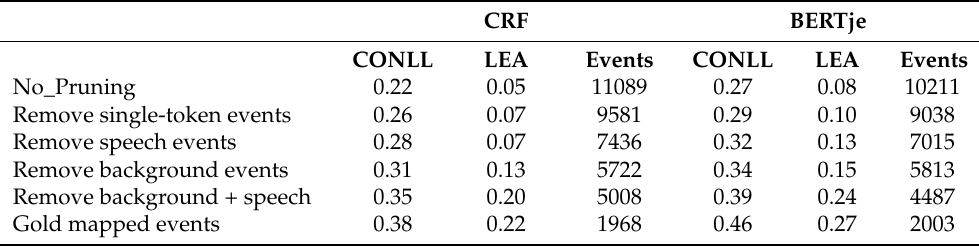
Table 5. Effects of pruning heuristics showing the influence on the CONLL and LEA scores as well as the total number of events